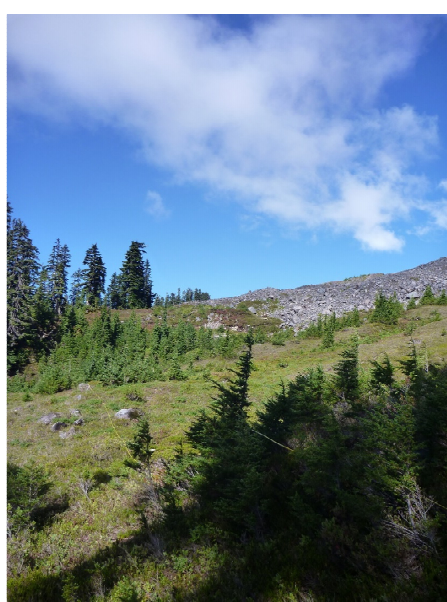
Figure A1. Scott Paul East transect crosses a meadow directly below end moraines Squak glacier.